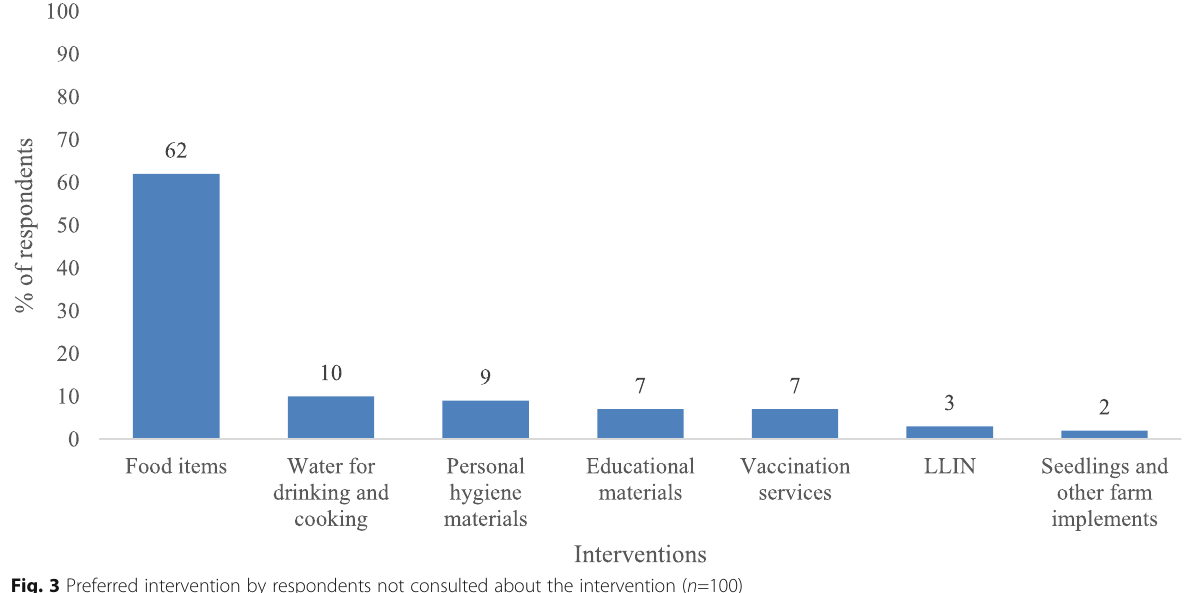
Fig. 3 Preferred intervention by respondents not consulted about the intervention ( n =100)